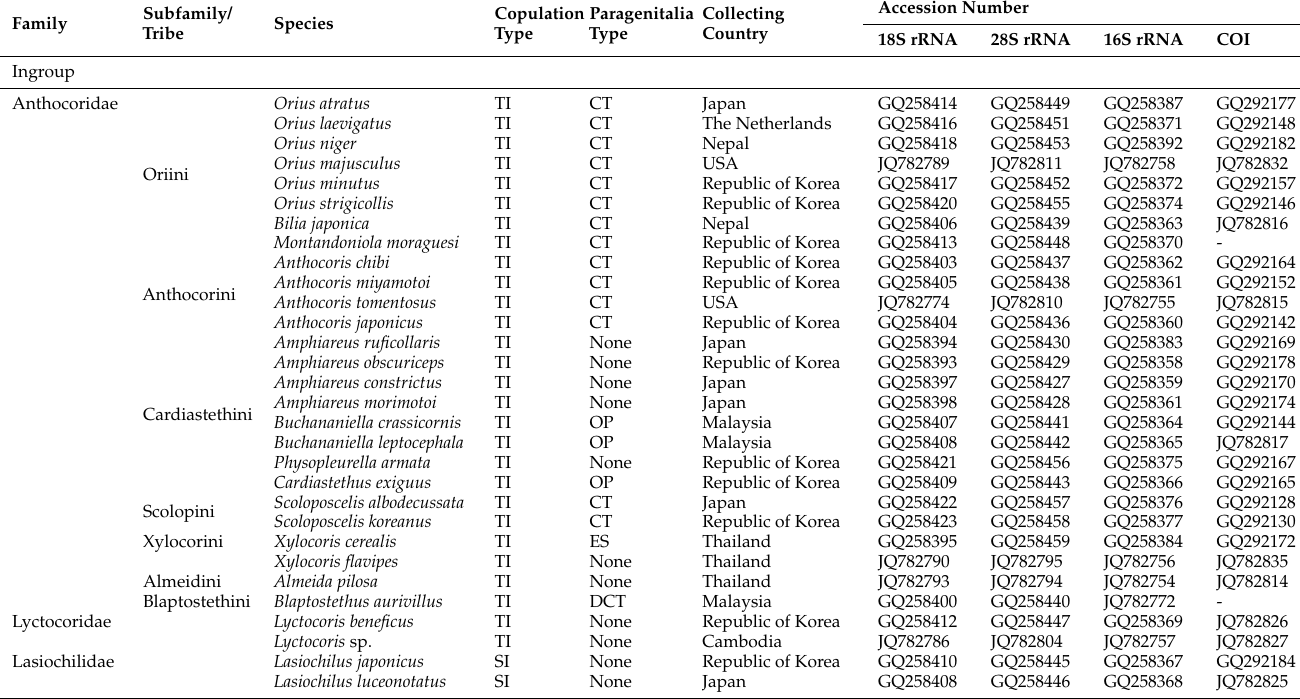
Table 1. GenBank accession numbers and character coding of copulation habits and parageni- talia